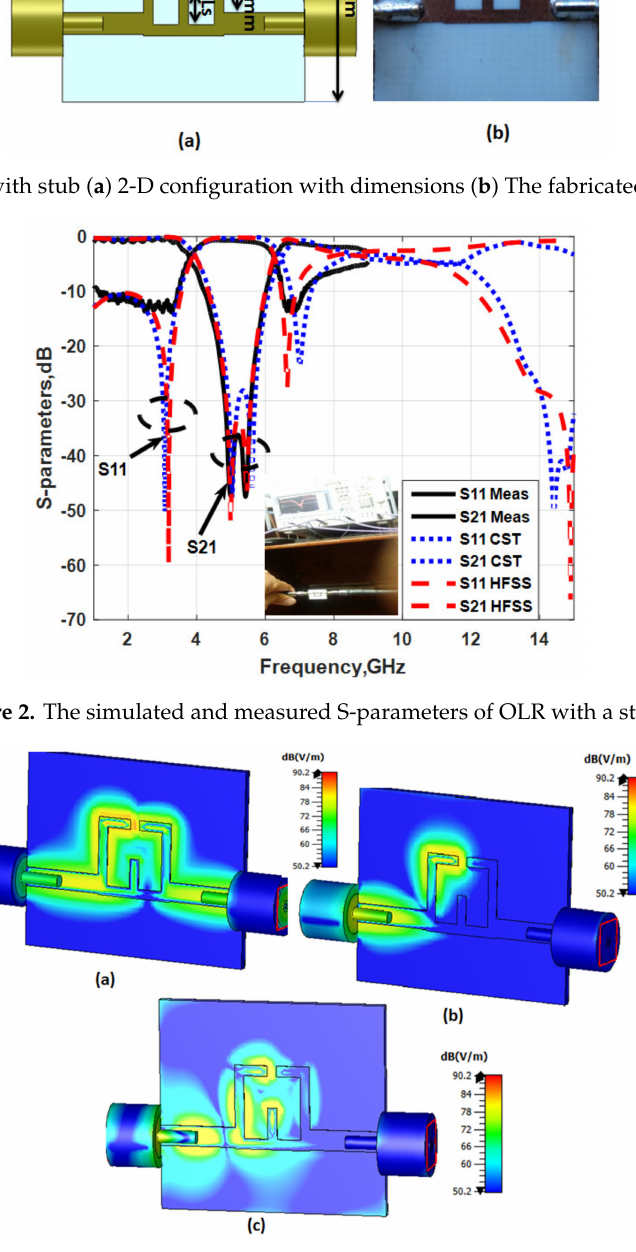
Figure 3. The electric field results of OLR with stub ( a ) at 2.5 GHz ( b ) at 5.5 GHz ( c ) at 14.5